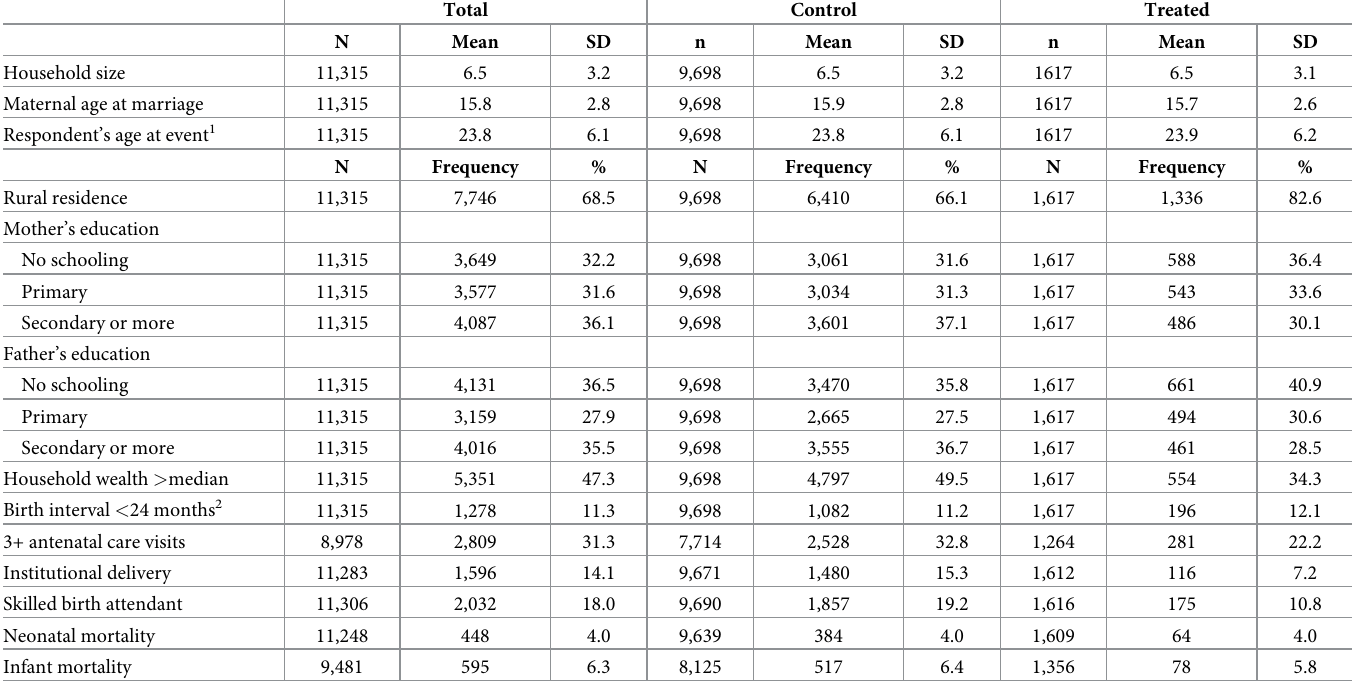
Table 2. Sample characteristics for analyses of live births from the period prior to the introduction of the MHVS in treated upazilas (before December 2006); BDHS data.